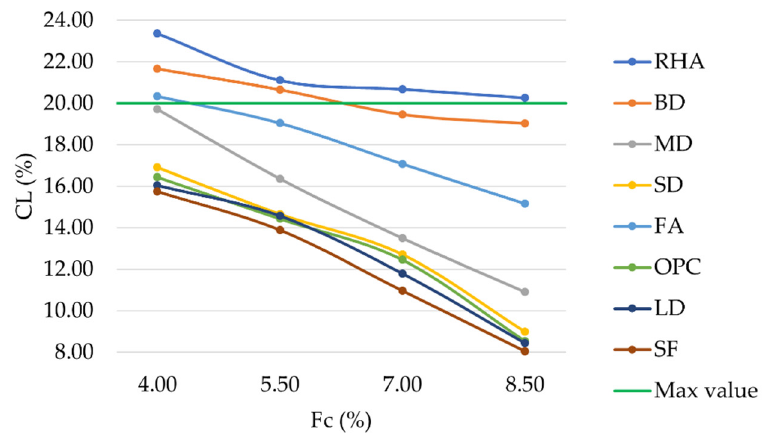
Figure 11. Cantabro loss vs. filler content for mixtures prepared with conventional and waste fillers.